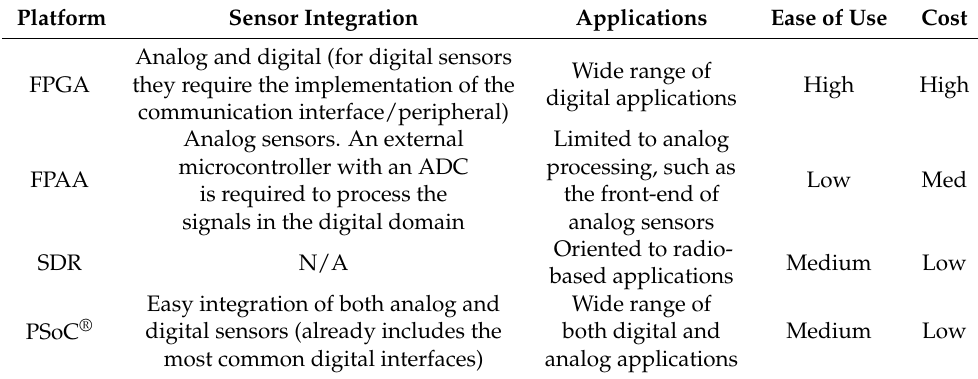
Table 1. Comparison among reconfigurable electronics platforms. Platform Sensor Integration Applications Ease of Use Cost Analog and digital (for digital sensors FPGA they require the implementation of the communication interface/peripheral) Analog sensors. An external microcontroller with an ADC FPAA is required to process the signals in the digital domain SDR N/A